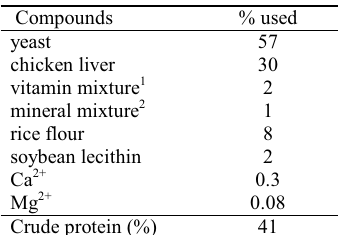
CaCO (experiment 1, concentrations mg.L -1 : 5.2 Ca 2+ and 14.12 3 Mg 2+ ; 13.11 Ca 2+ and 7.11 Mg 2+ ; 20.26 Ca 2+ and 2.86 Mg 2+ ; 24.95 Ca 2+ and 0.95 Mg 2+ ) and 150 mg.L -1 CaCO 2, concentrations mg.L -1 : 5.2 Ca 2+ and 32.70 Mg 2+ ; 28.63 Ca 2+ and 16.44 Mg 2+ ; 44.68 Ca 2+ and 6.44 Mg 2+ ; 62.78 Ca 2+ and